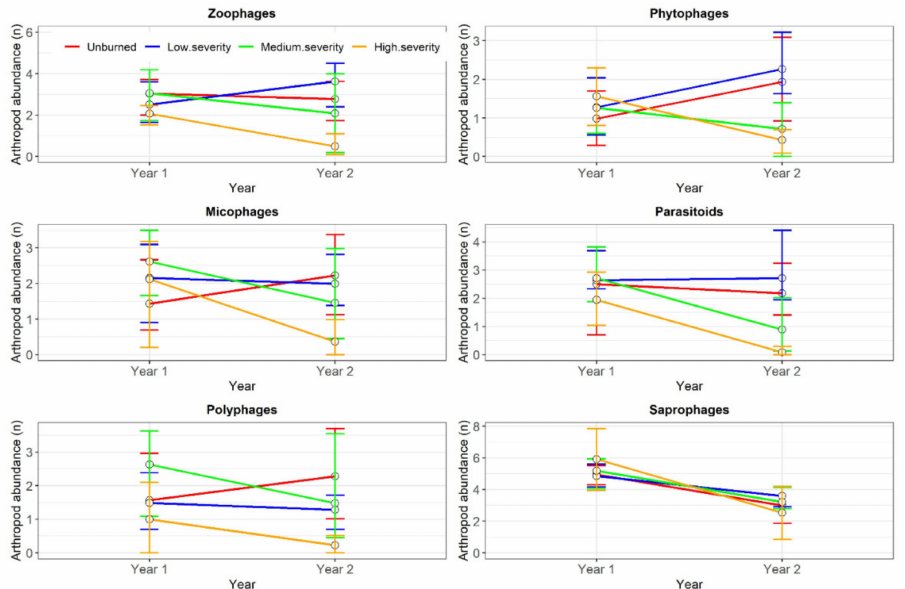
Figure 3. Abundance of arthropods belonging to different guilds under different fire severity treat- ments collected during two sampling years (2017 and 2018).